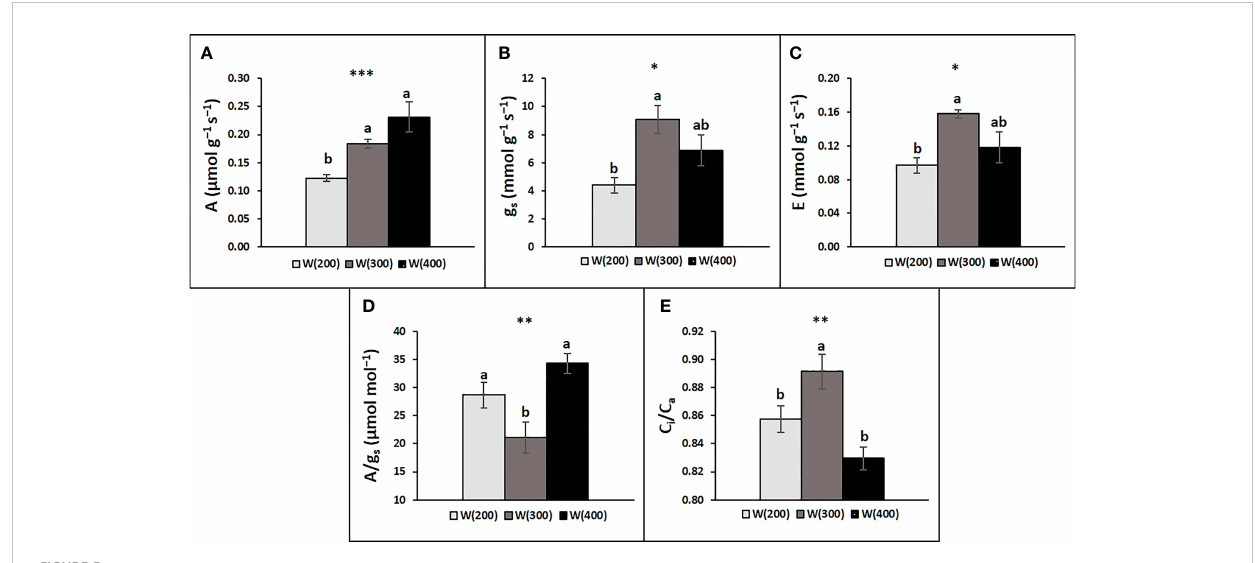
FIGURE 5 Leaf gas exchange responses of perennial ryegrass (cv. Double) to the different LED illumination regimes, 100% cool white at 200 [W(200)], 300 [W (300)] and 400 [W(400)] m mol m − 2 s − 1 . Net photosynthetic rate (A , a ) , stomatal conductance ( g s , B) , transpiration rate (E, C) , intrinsic water use ef fi ciency (A/g s , D ), and ratio of intercellular to atmospheric CO 2 concentration (C i /C a , E ). Each column is average and vertical bars represent the S.E. (n = 18). Different letters indicate signi fi cant differences among the treatments (*p<0.05; **p<0.01;